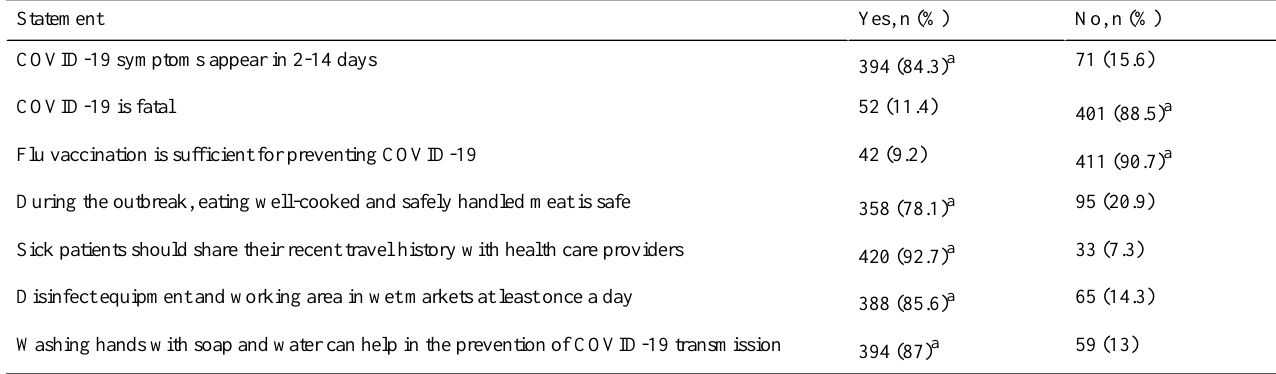
Table 4. Health care workers’perceptions toward coronavirus disease 2019 (COVID-19)